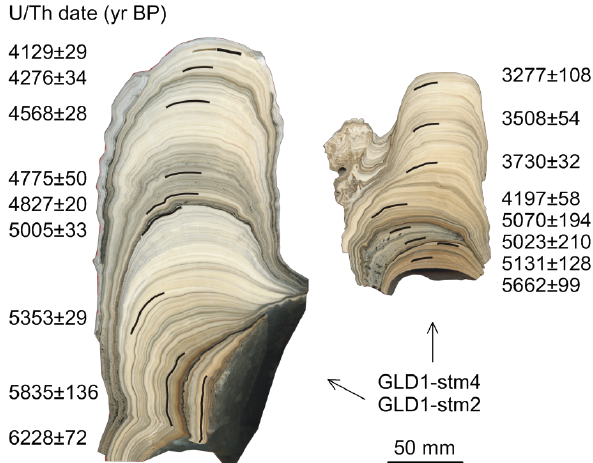
Figure 2. U/Th dating of stalagmites GLD1-stm2 and GLD1-stm4 from the Gueldaman GLD1 Cave. U/Th dates and 2 σ errors are shown next to sampling